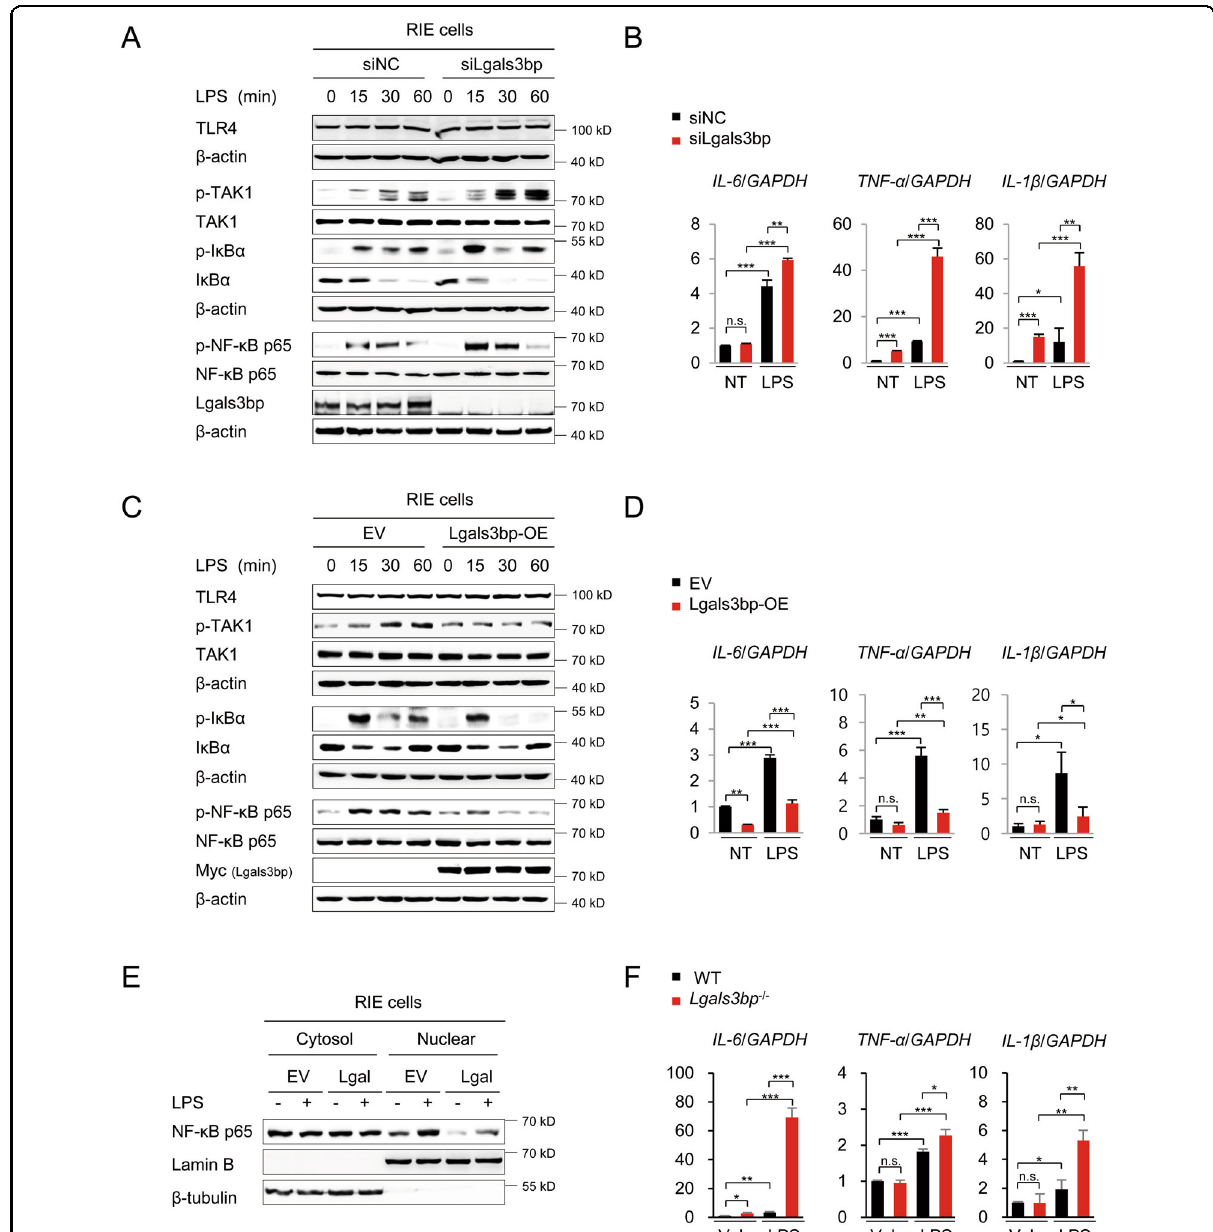
Fig. 4 Lgals3bp-induced downregulation of NF- κ B-in fl ammatory cytokine axis via TAK1 suppression in epithelial cells. A – B Lgals3bp - knockdown RIE cells were treated with LPS (100 ng/ml) for indicated periods. A Whole cell lysates were analyzed for the activation of TLR4, TAK1, I κ B, and NF- κ B via western blotting. B RNA was isolated from LPS-treated RIE cells, and the expression of the indicated genes was analyzed by RT-qPCR. C , D Lgals3bp -overexpressed RIE cells were treated with LPS (100 ng/ml) for indicated periods. C Whole cell lysates were analyzed for TLR4, TAK1, I κ B, and NF- κ B activation by western blotting. D RNA was isolated from LPS-treated RIE cells, and IL-6, TNF- α , and IL-1 β gene expression levels were analyzed by RT-qPCR. E Lgals3bp -overexpressed RIE cells were treated with LPS (100ng/ml) for 15 min. The expression level of NF- κ B p65 was analyzed in the cytoplasmic and nuclear fractions. β – tubulin and lamin B were used as the loading controls for the cytosol and nucleus, respectively. F Primary colon epithelial cells were isolated from WT and Lgals3bp − / − mice, and treated with LPS (100ng/ml) for 3 h. The expression of indicated genes was analyzed by RT-qPCR. Data are presented as means ± SEM values. * p < 0.05; ** p < 0.01; *** p < 0.001; **** p <